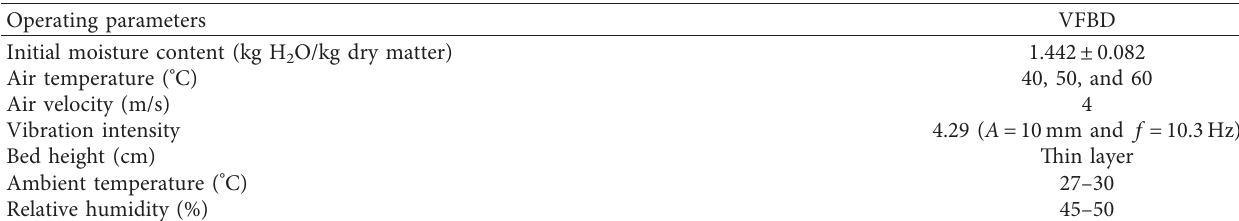
Table 2: Experimental parameters for